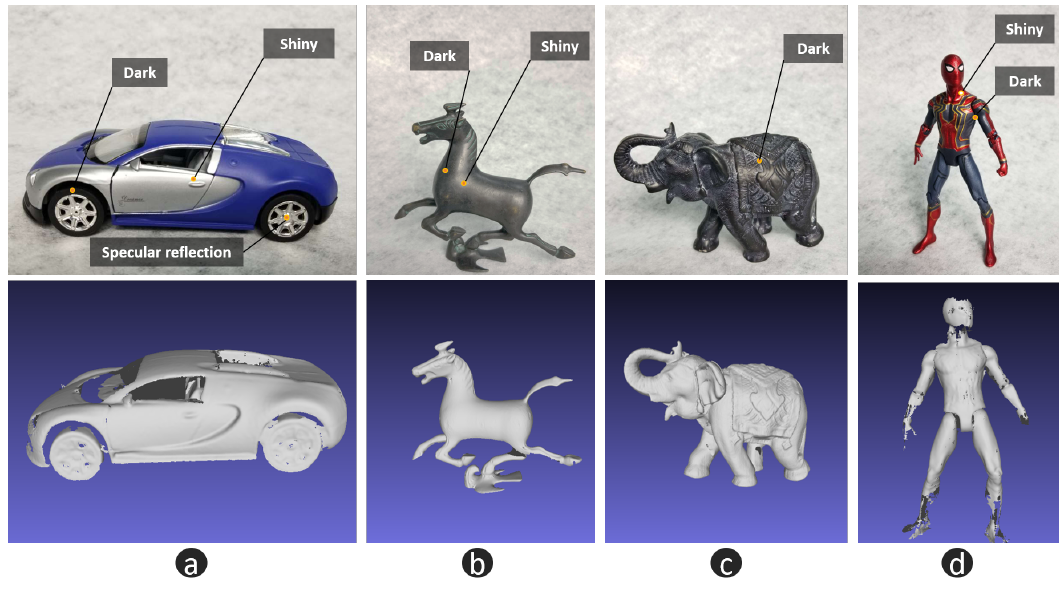
Figure 13. Experimental results of the proposed hybrid measurement approach. ( a ) plastic surface with shiny, dark and specular reflection regions; ( b ) metal surface, which results in shiny and dark regions from different perspectives of observation; ( c ) stone material with very low reflection; ( d ) plastic surface with multiple reflectance and large variation of normal